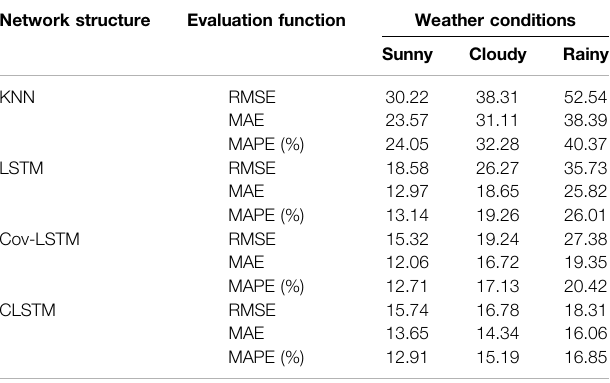
TABLE 3 | Comparison of the prediction results of four models.